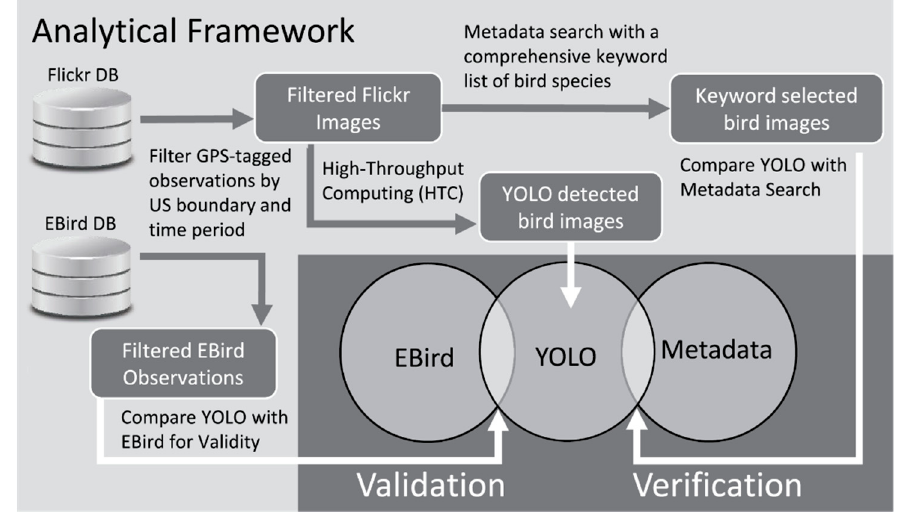
Figure 1. Overview of the analytical workflow.